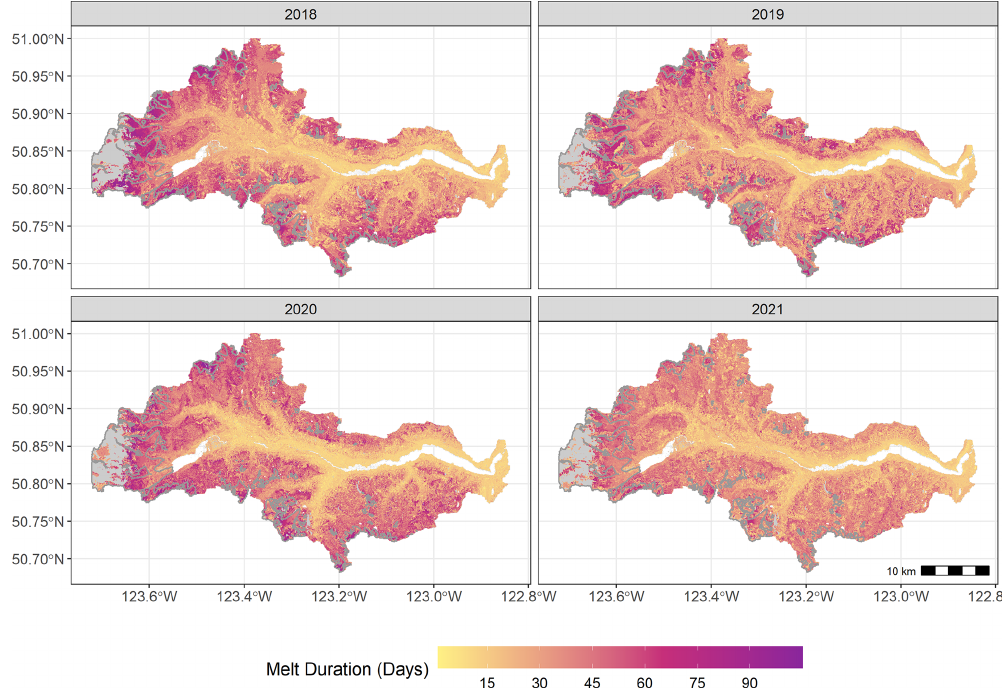
Figure 9. Snowmelt runoff duration in the La Joie Basin from optical-radar melt products. Duration is approximated by differencing radar estimates of snowmelt onset and optical and multispectral estimates of snow-free dates. Grey shading represents perennial snow, and the grey outlines delineate